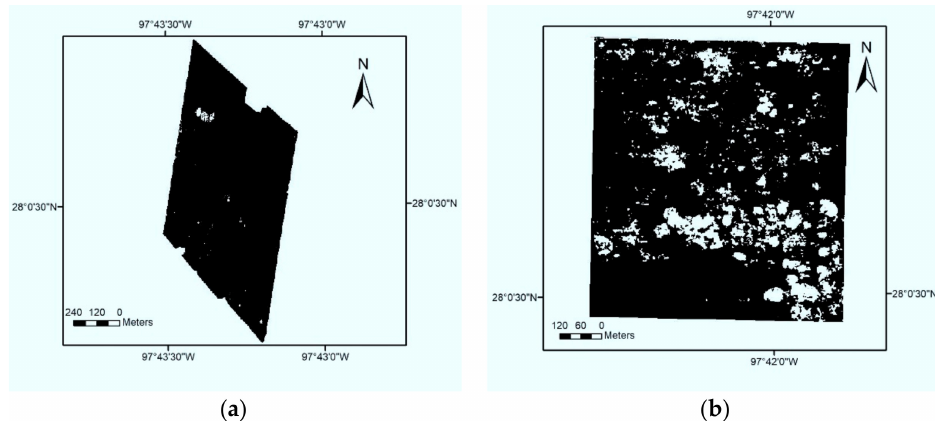
Figure 3. Classification maps for two fields: ( a ) Field A and ( b ) Field B. White within each field represents root rot areas, while black depicts non-infested areas.